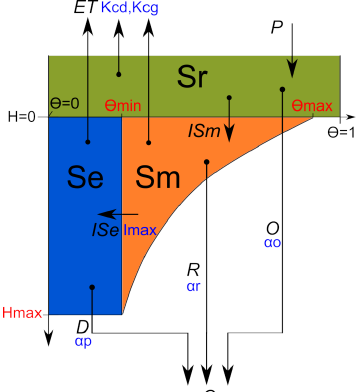
Figure 2. Structure of the hydrological model, composed of the three reservoirs of surface (Sr), macroporosity (Sm) and retention (Se). The different fluxes are indicated in italics: P (precipitation), ET (evapotranspiration), ISm (infiltration from Sr to Sm), ISe (infil- tration from Sm to Se), D (deep drainage from Se), R (runoff from Sm) and O (overland flow from Sr). Total discharge Q corresponds to the sum of D , R and O . Note that given parameters are in red and calibrated parameters associated with each flux are in blue (see description in Table